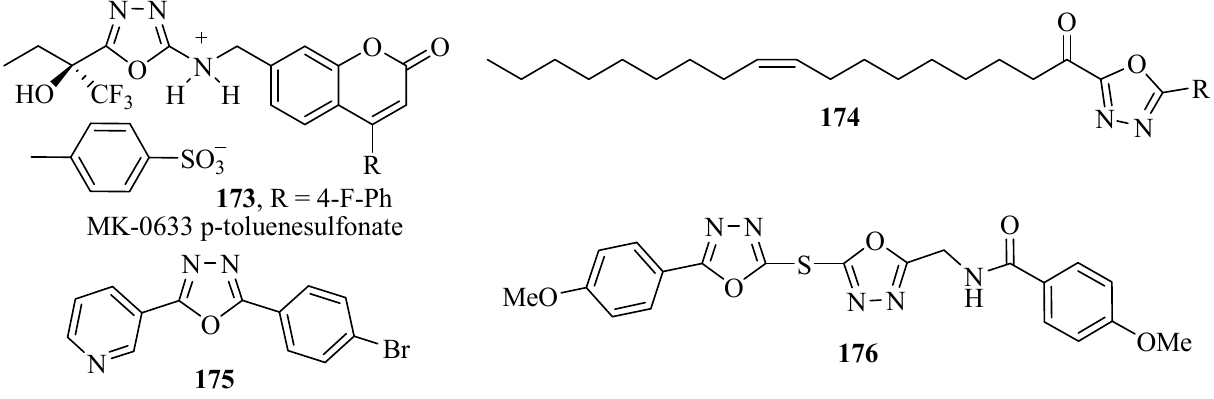
Figure 15. 1,3,4-Oxadiazole as enzyme